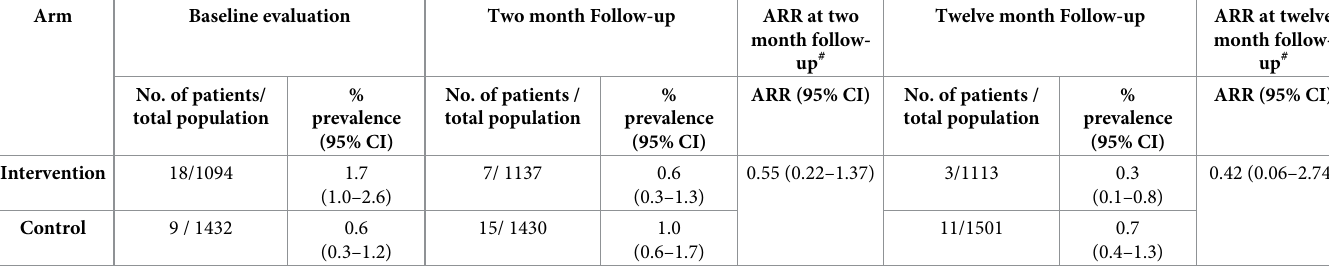
Table 4. Prevalence of impetigo at baseline, two and twelve months follow-up evaluation in the two arms of the study.